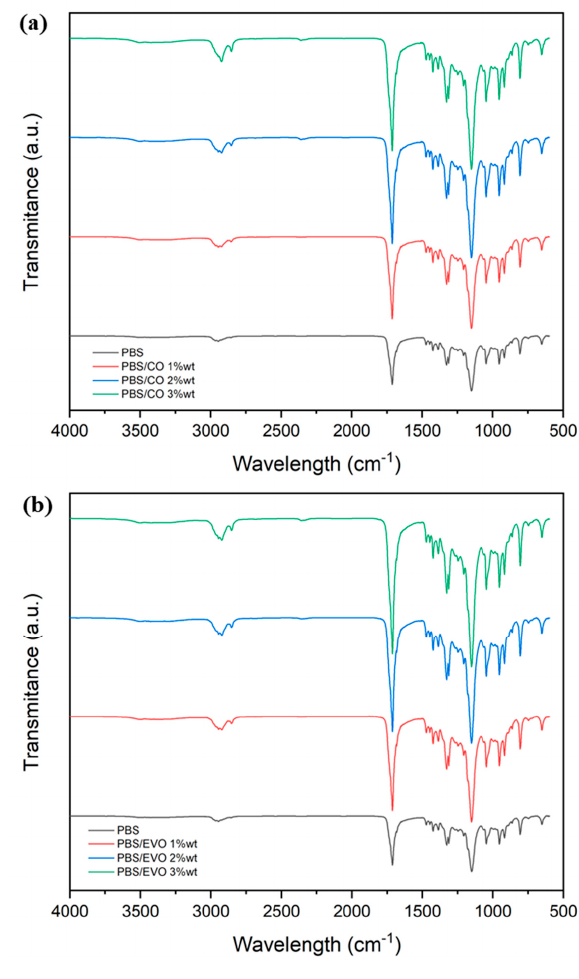
Figure 4. FTIR spectra of: ( a ) PBS and PBS/CO formulations and ( b ) PBS and PBS/EVO formulations.